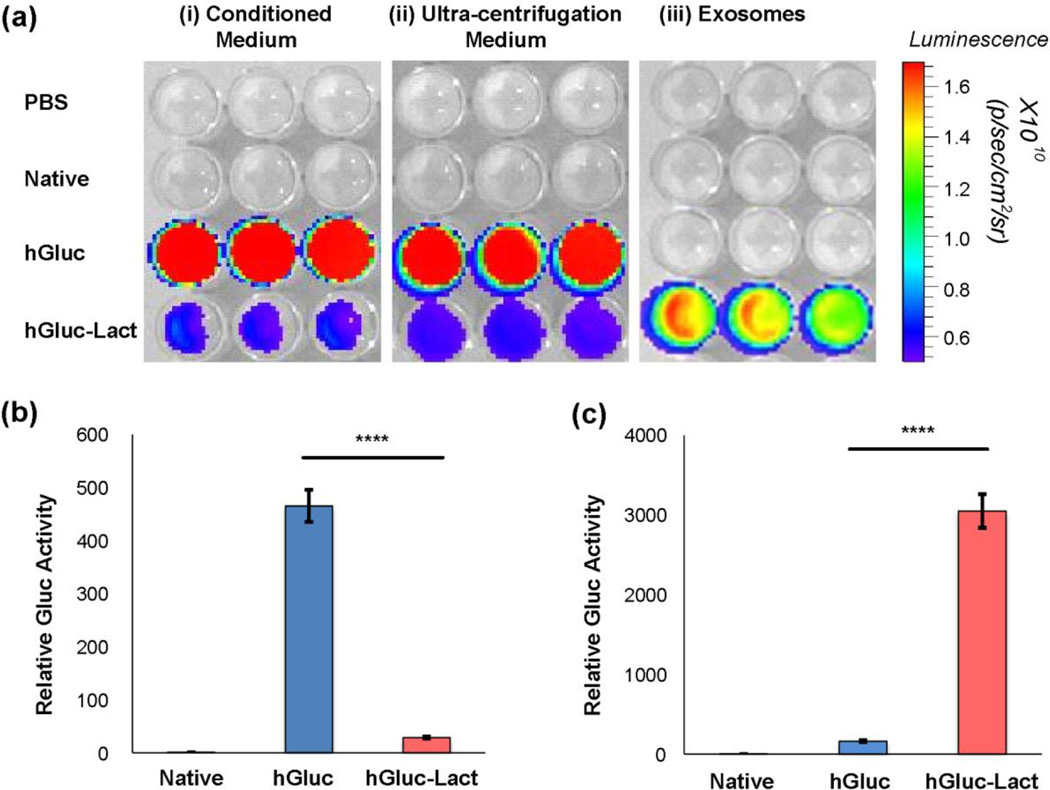
Validation of hGluc-labeled exosomes using in vitro bioluminescence Assays(a) In vitro bioluminescence assay of conditioned medium, ultra-centrifugation supernatant and exosomes. (i) Conditioned medium collected from 293T cells, (ii) supernatant collected after serial steps of ultra-centrifugation and (iii) exosomes purified from 293T cells through ultra-centrifugation were diluted in PBS. CTZ was then added at a final concentration of 25 µM. Gaussia luciferase (hGluc) activity was measured using IVIS Lumina (exposure time 0.5s). (b) hGluc activity was significantly higher in conditioned medium. Error bar: mean ± SEM. ****P < 0.0001. (c) After ultra-centrifugation, hGluc activity was mainly detected in hGluc-Lact exosomes, indicating hGluc was enriched on exosomes. Error bar: mean ± SEM. ****P < 0.0001.